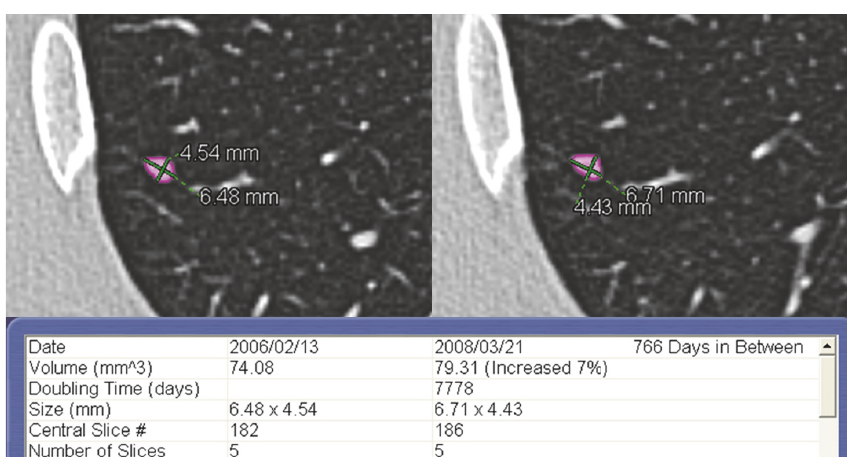
Figure 2: Solid pulmonary nodule smaller than 100mm 3 with smooth margins located in the right lower lobe in a 36-year-old low-risk male patient. Baseline (left) and last follow-up CT scans (right). The interval between the two CT examinations was 766 days. The software did not show significant growth of the nodule (relative volume variation of 7% with a volume doubling time of 21 years). The unequivocal nodule stability after more than 2 years indicates the benign nature of the lesion. In this case, the new Fleischner Society guidelines would not have recommended a follow-up CT